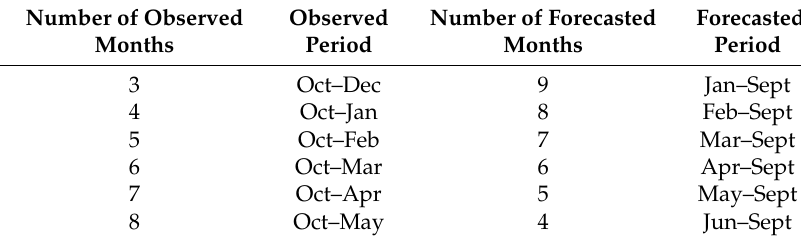
Table 1. Relationship between the observed and forecasted